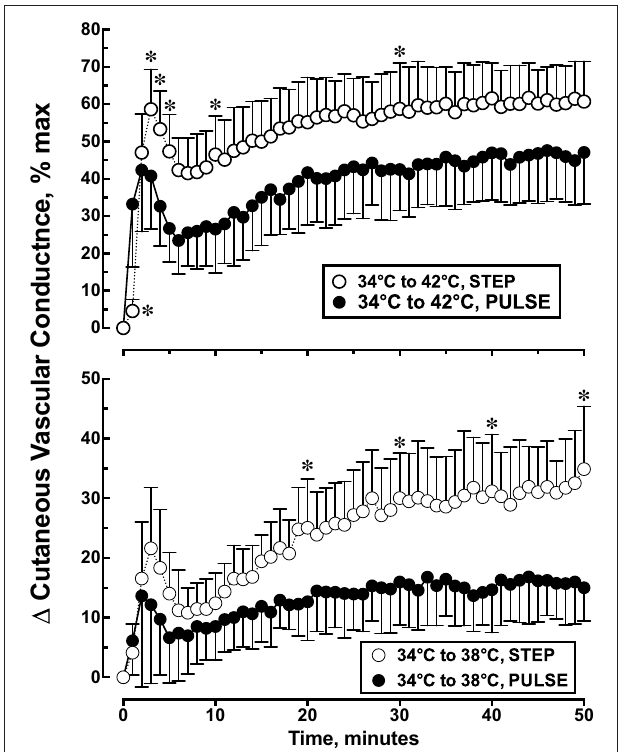
FIGURE 3 | Cutaneous vascular conductance response to local skin heating during: (1) a single step change in local skin temperature from 34 to 38 ◦ C ( n = 10), (2) a single step change in local skin temperature from 34 to 42 ◦ C ( n = 10), (3) pulsed heating, 1 pulse per min, each pulse represented a step change in local skin temperature from 34 to 38 ◦ C, rate of change = 1.0 ◦ C • s − 1 , 50% duty cycle, n = 10 or (4) pulsed heating, 1 pulse per min, each pulse represented a step change in local skin temperature from 34 to 42 ◦ C, rate of change = 1.0 ◦ C • s − 1 , 50% duty cycle, n = 9. Values represent the mean ± 1 SD. * p < 0.05 STEP differs from PULSE.